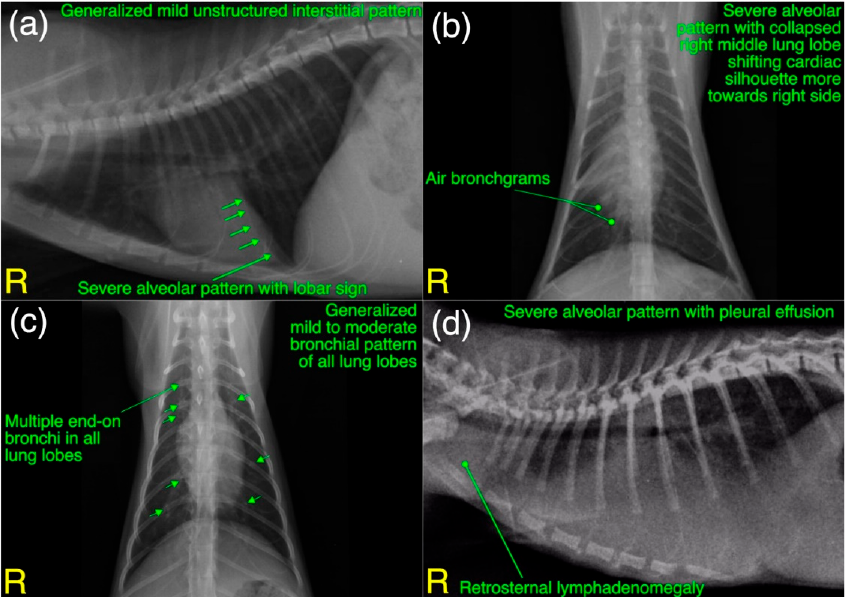
Figure 13. ( a – d ) A variety of radiographic changes (patterns) of thoracic cavity are labeled for pathologies related to acute/chronic infectious respiratory disease signs in Cats 15, 18 and 25. Laterality is also labeled for each radiograph.